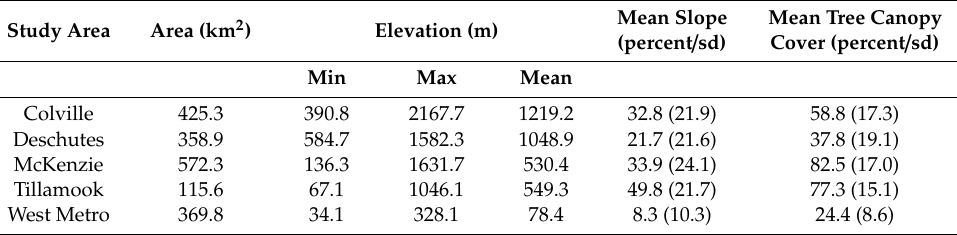
Figure 1. Spatial distribution of study areas, each featuring National Agriculture Imagery Program (NAIP) panchromatic imagery co-temporal to the ALS data acquisition and a digital terrain model generated from the laser data with superimposed platform trajectory lines displayed in red. Scale varies across the five study areas. Table 1. Physiographic metrics of study areas.